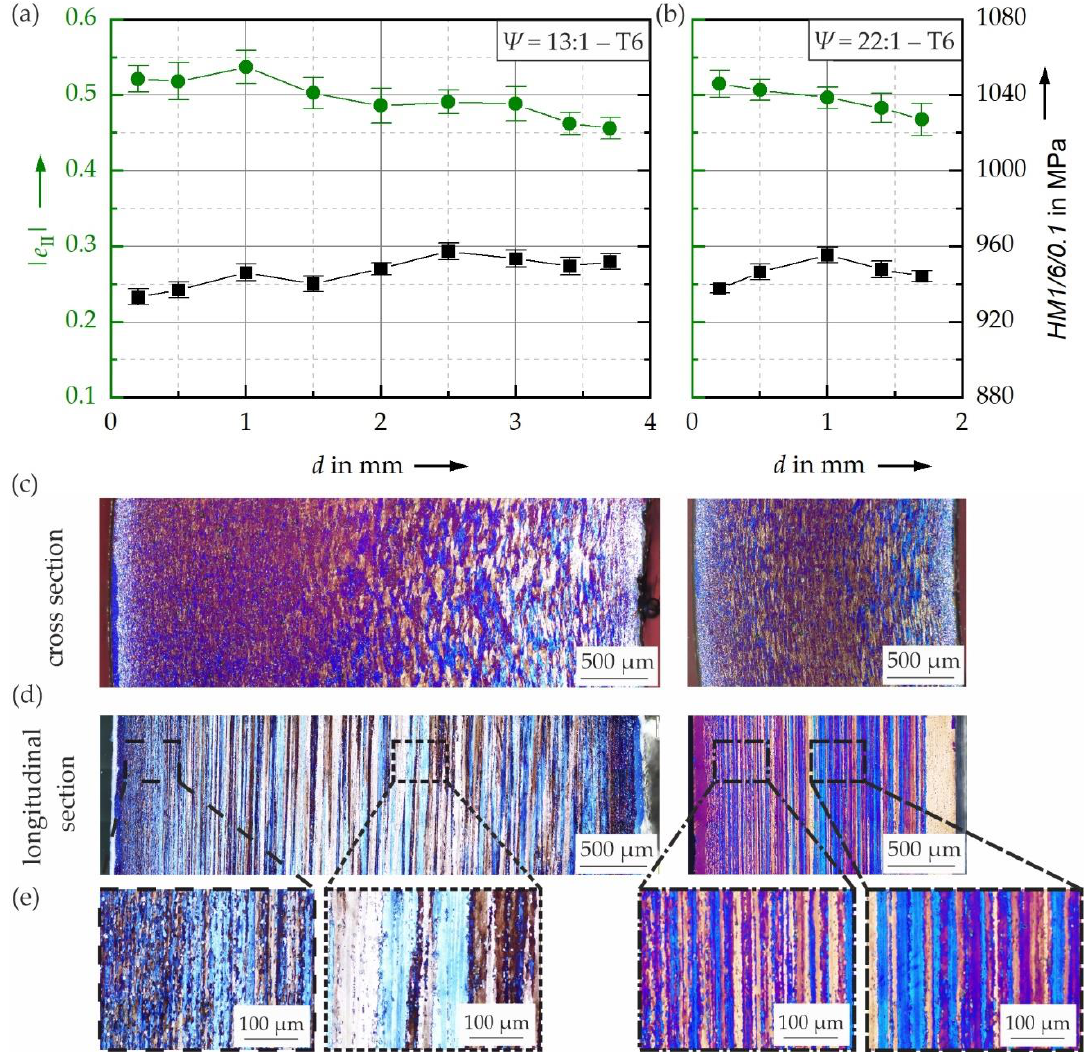
Figure 6. Martens hardness HM1/6/0.1 and cyclic hardening exponent CHT | e II | of T6 heat-treatment state with ( a ) Ψ of 13:1 and ( b ) Ψ of 22:1 depending on the distance d from the outer surface; light optical micrographs of ( c ) cross sections and ( d ) longitudinal sections as well as ( e ) close-up views.